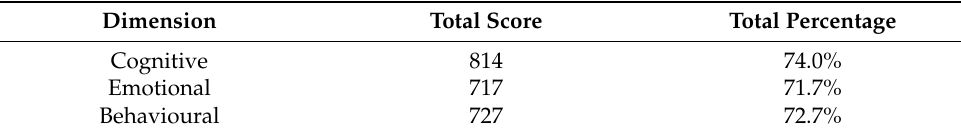
Table 3. Total score and percentage per engagement dimension.